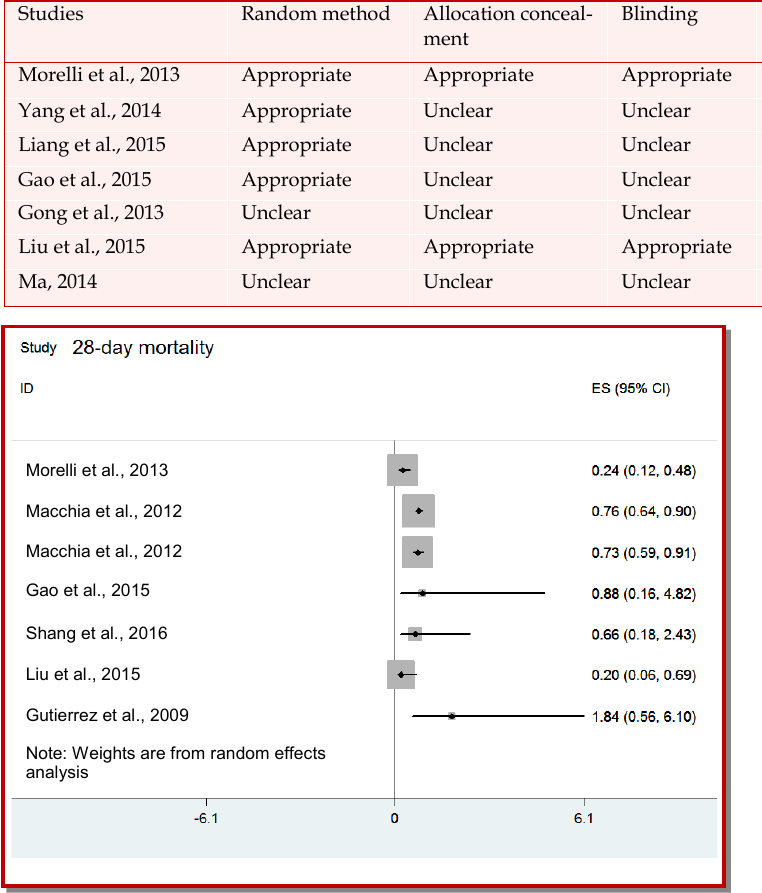
Figure 2: Meta-analysis of beta-blocker on the 28-day